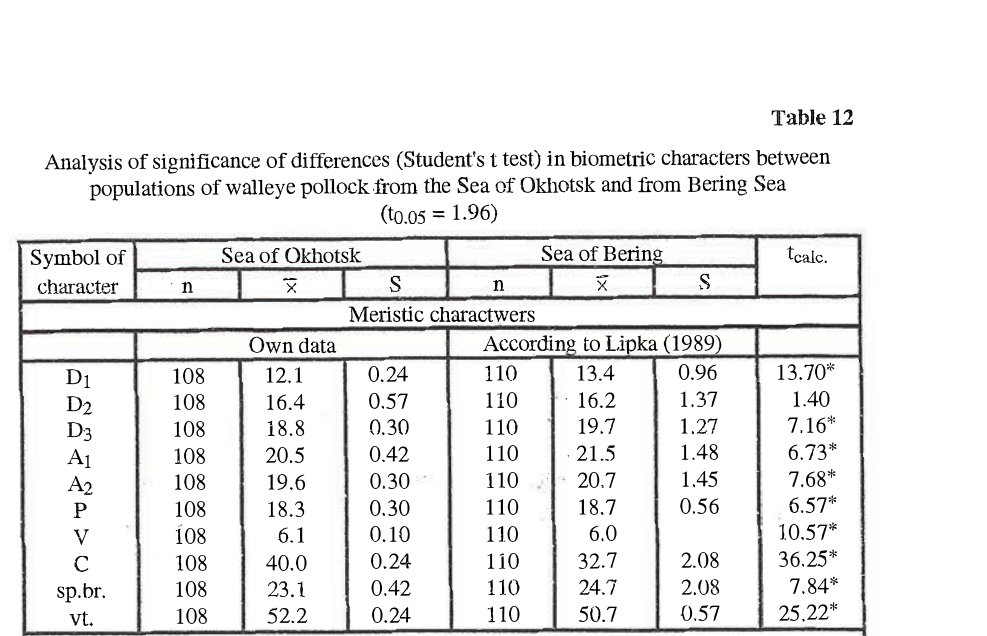
characters between